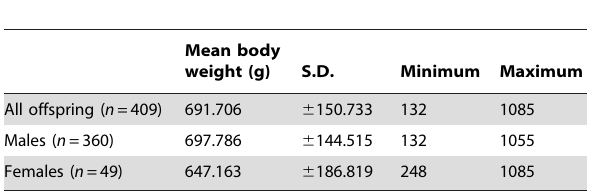
Table 2. Mean body weight (g) and standard deviation (S.D.) of S . aurata male, female and all offspring.